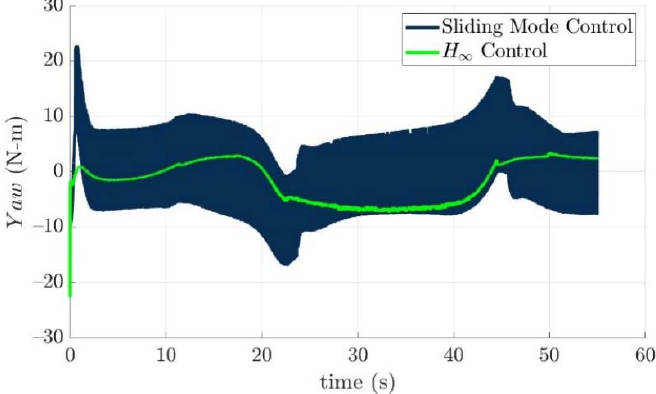
Figure 20. Yaw moments of the developed torpedo-like underwater vehicle with respect to the slid-